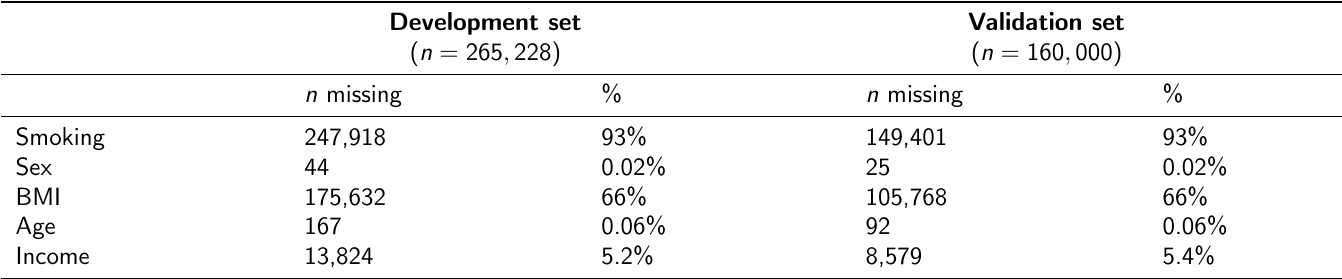
Table 2: Predictors with missing data